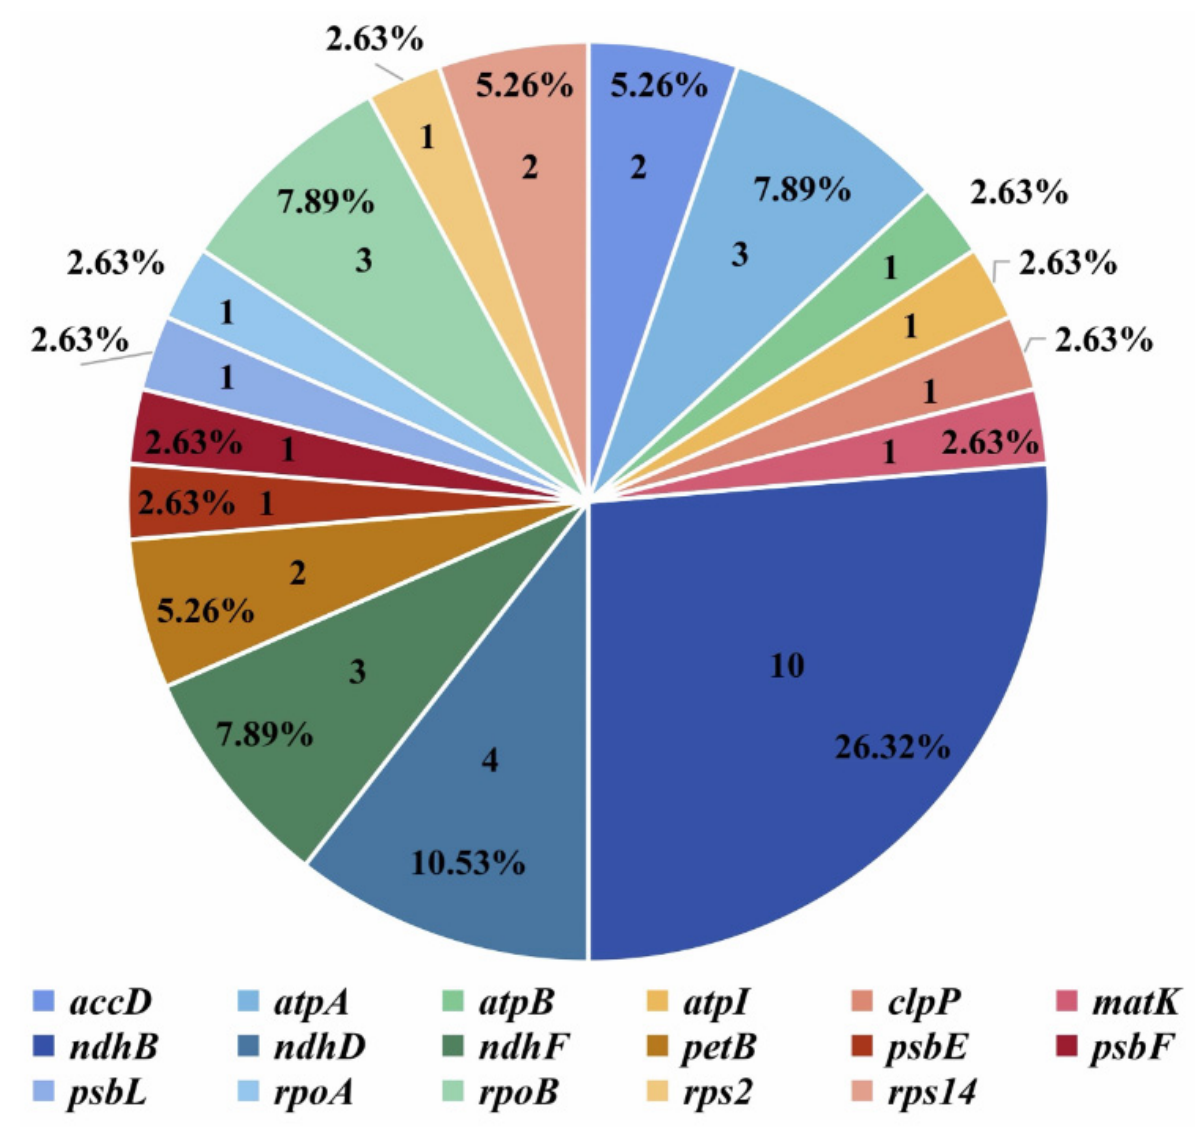
Figure 5. The predicted RNA editing sites in protein-coding genes of P. fortuneana chloroplast ge- nomes.